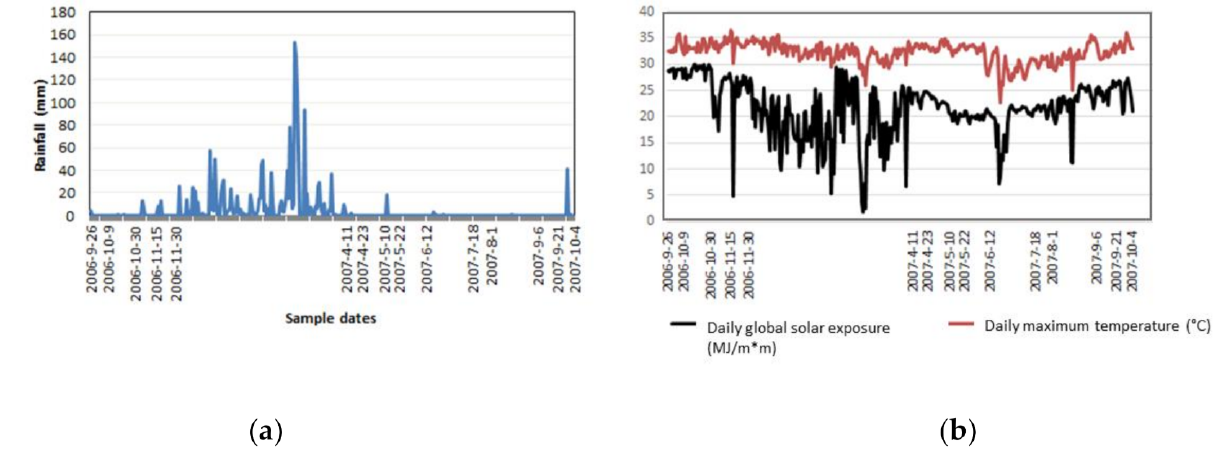
Figure 5. ( a ) Rainfall, ( b ) temperature and solar exposure patterns during the spectral sampling period (adapted from